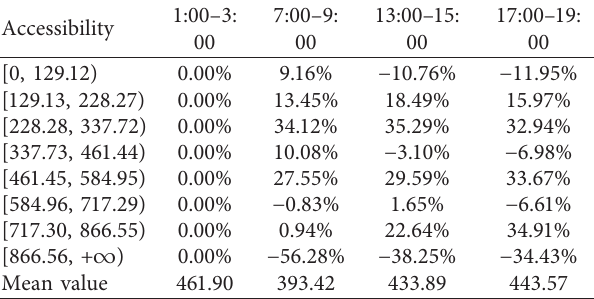
Table 3: Proportion changes of healthcare accessibility at different time